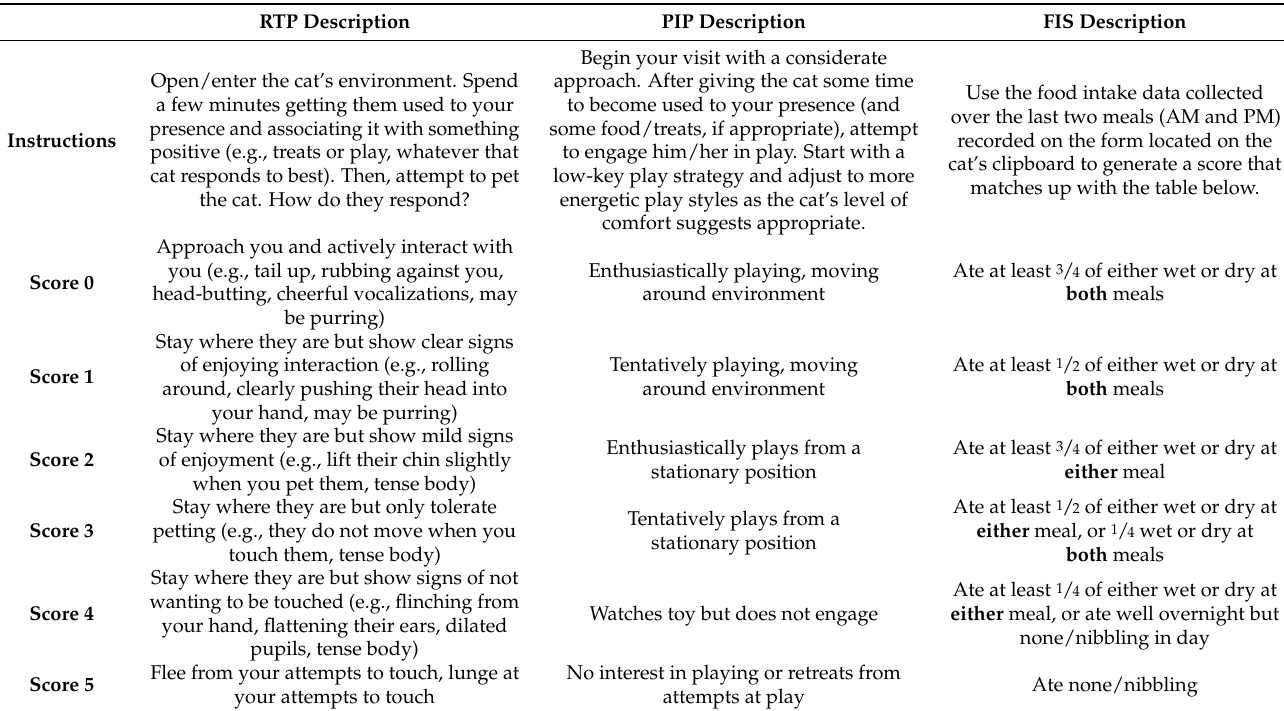
Table 3. Instructions and operational definitions of the levels of the RTP, PIP, and